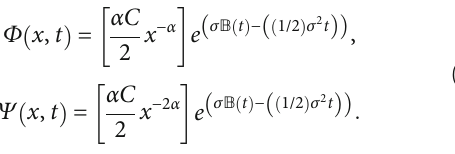
ffiffiffiffiffiffiffiffiffiffiffiffiffi − q /2 ð